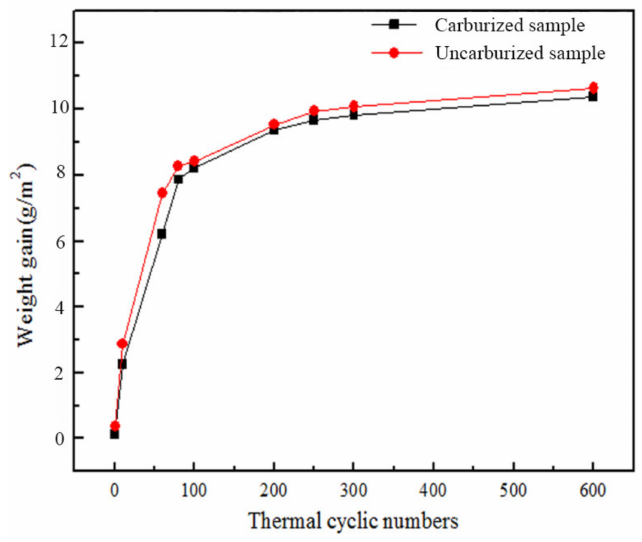
Figure 4. The kinetic curves of thermal cyclic oxidation of the carburized and uncarburized DD10 superalloys with an HY5 coating at 1100 ◦